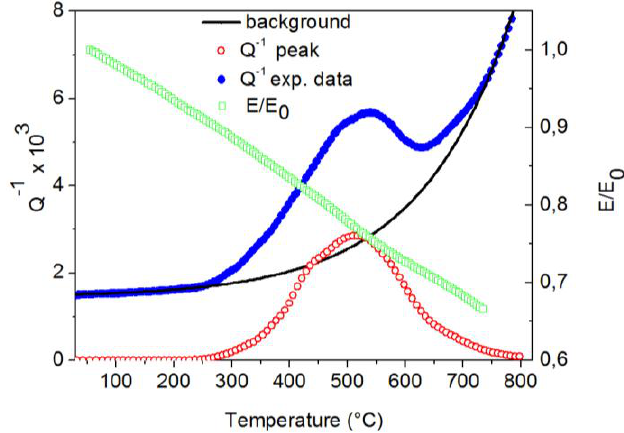
Figure 9. Q − 1 and E / E 0 vs. temperature of the steel heat treated for 2 h at 800 ◦ C. Resonance frequency f = 750 Hz.